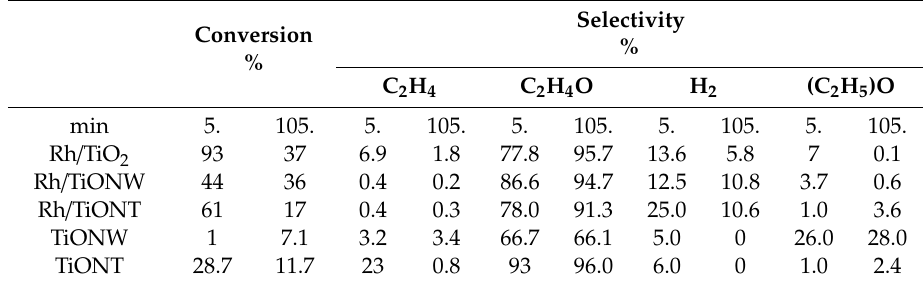
Table 4. Conversion and selectivity data measured in the ethanol transformation reaction on titania- and titanate-supported Rh catalysts.